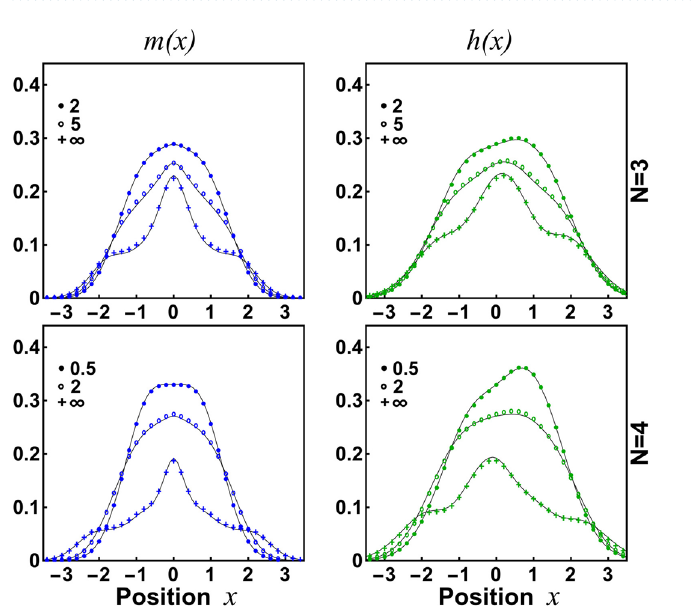
Figure 3. Single-particle density profile n ( x ) and different interaction strengths. Three consecutive columns correspond to three different types of the confinement with parameters ( (cid:31) , δ , ξ) Independently on the shape of the trap and interaction strength, the density profile predicted by the ansatz (red symbols) is in full agreement with numerically exact results (solid lines).